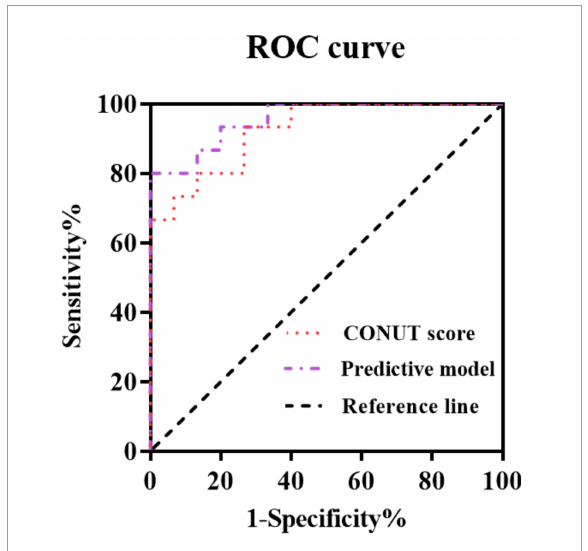
FIGURE1 Curves for predicting the prognosis of patients with human immunodeficiency virus (HIV) infection-associated lymphoma by indicators.